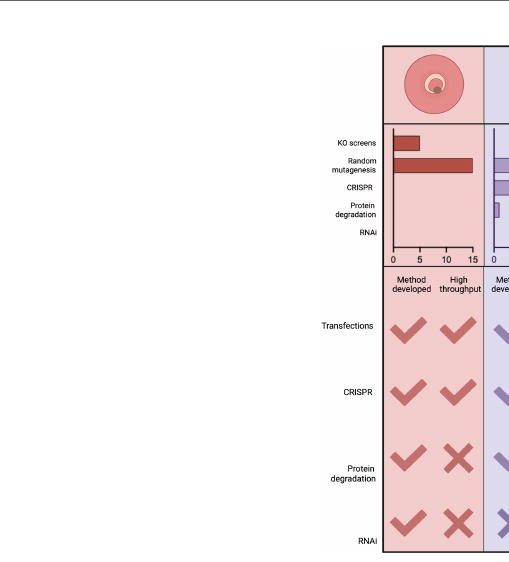
FIGURE 7 | Publications using functional screens in Apicomplexans and Kinetoplastids. The number of functional screens completed in various Apicomplexans and Kinetoplastids is summarised. PubMed searches were carried out for each genus and screening method (y-axis) manual curation con fi rmed whether the method was used for screening rather than follow-up studies. In Plasmodium spp. random insertional mutagenesis ( pf) and KO screens ( pb) have been used extensively. In T. gondii chemical mutagenesis and, more recently, mutagenesis using CrispR libraries dominate. Functional screens in Trypanasoma spp. have been exclusively and extensively completed using RNAi. Few screens have been completed in Leishmania spp. and these are recent. Due to the lack of high throughput technologies in Cryptosporidium spp. no screens have been carried out on the parasites, only host screens. A summary of currently available technologies and their adaptation to high throughput, required for screening, is also shown. Figure created with